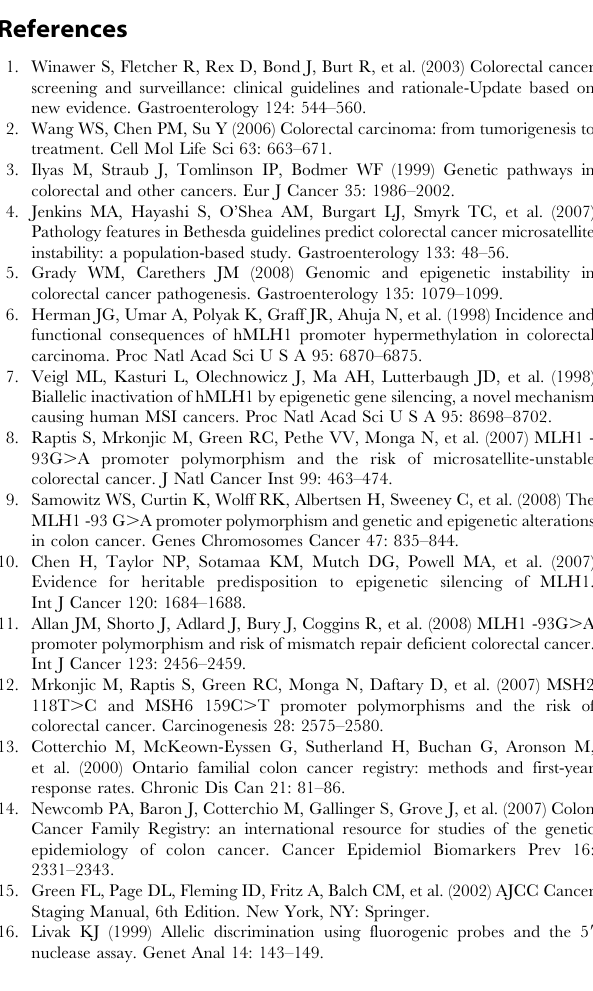
Figure S1 D-Prime map of all SNPs genotyped in Ontario samples. Figure S2 R-squared map of all SNPs genotyped in Ontario